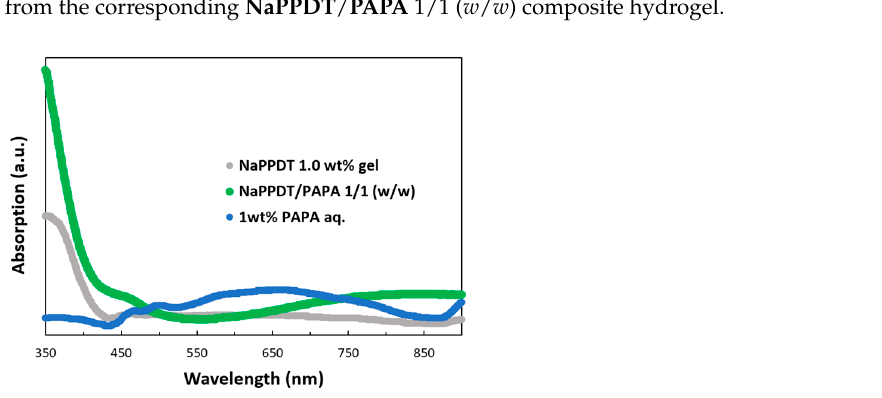
Figure 4. Scanning electron microscopy (SEM) images of xerogels and the dried sample obtained from freeze-drying method: ( a ) NaPPDT xerogel prepared from the corresponding NaPPDT 1.0 wt% hydrogel, ( b ) dried sample of 1.0 wt% PAPA aq., ( c ) NaPPDT / PAPA composite xerogel prepared from the corresponding NaPPDT / PAPA 1/1 ( w / w ) composite hydrogel.